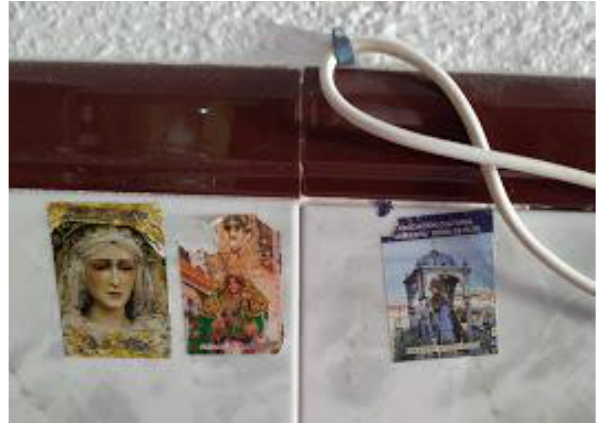
Photograph 5: Stickers of Virgin Mary statues on the wall of a care home bedroom. Photograph taken by author.